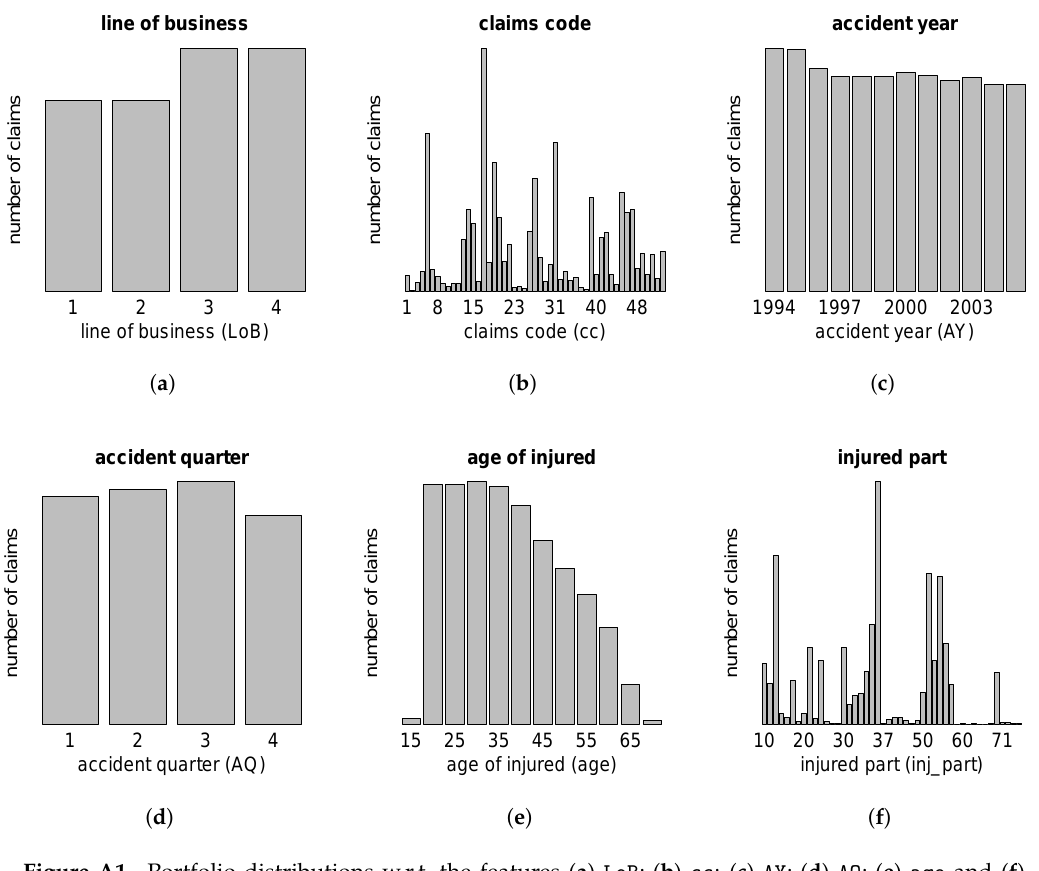
Figure A1. Portfolio distributions w.r.t. the features ( a ) LoB ; ( b ) cc ; ( c ) AY ; ( d ) AQ ; ( e ) age and ( f ) inj_part .